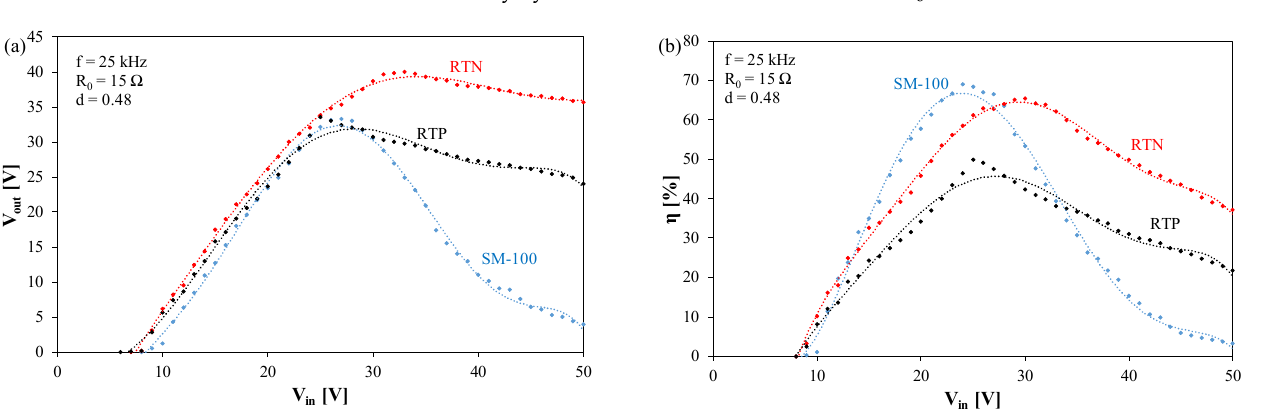
Figure 5. Measured dependences of the output voltage ( a ) and energy efficiency ( b ) of the tested DC-DC converter on its input voltage at R 0 = 15 Ω .